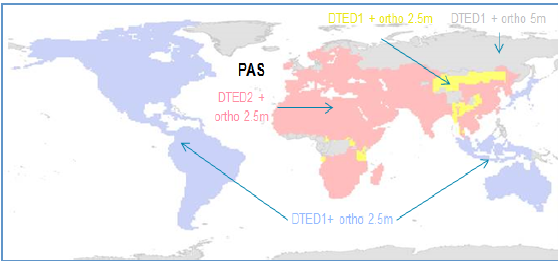
Figure 1. Airbus/IGN PAS dual layers database coverage. The area in pink also depicts the IGN BDAmer database